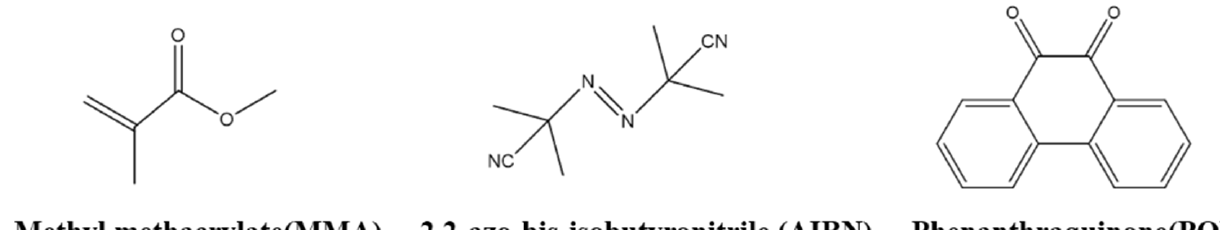
Figure 5. Schematic diagram of the chemical composition of PQ/PMMA photopolymers.